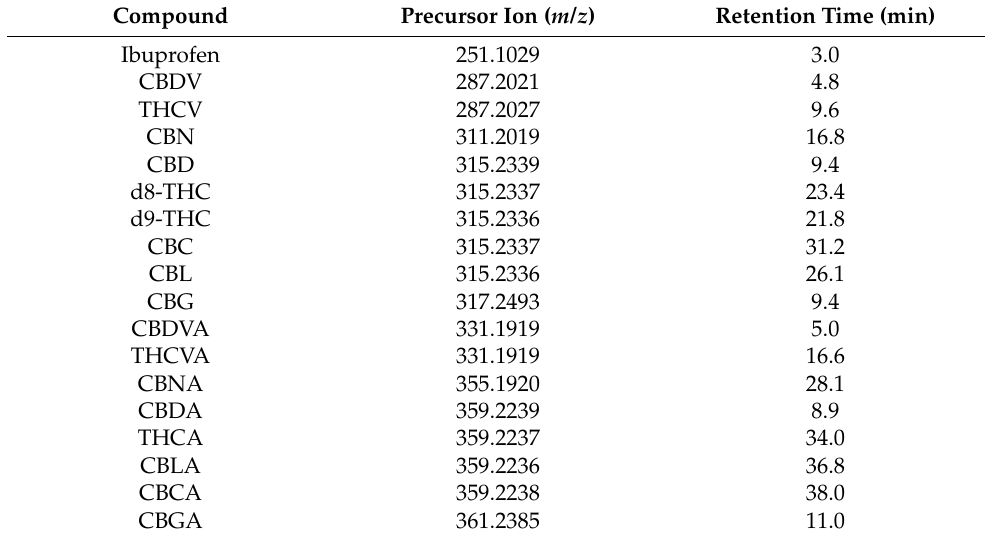
Table 1. Retention time and precursor ions used to extract and integrate chromatographic peak of each cannabinoid. A ± 0.03 m/z window was used to extract spectral